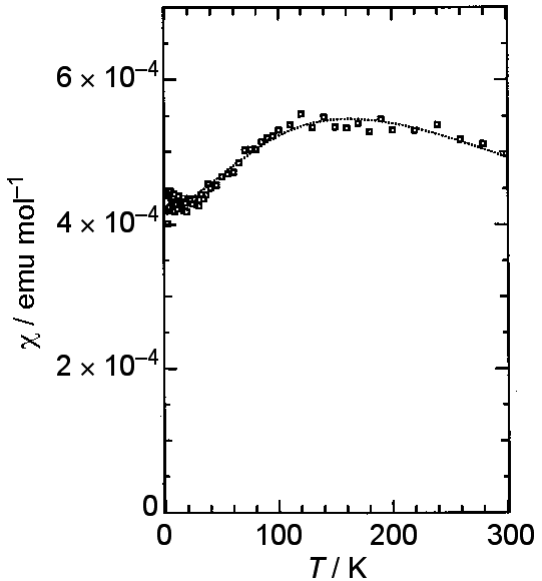
Figure 4. Temperature dependence of the susceptibility of β-(BDA-TTP) line represents a theoretical curve for the one-dimensional (1D) antiferromagnetic Heisenberg model with J = −125(3) K (Reprinted with permission from reference 20, The Royal Society of